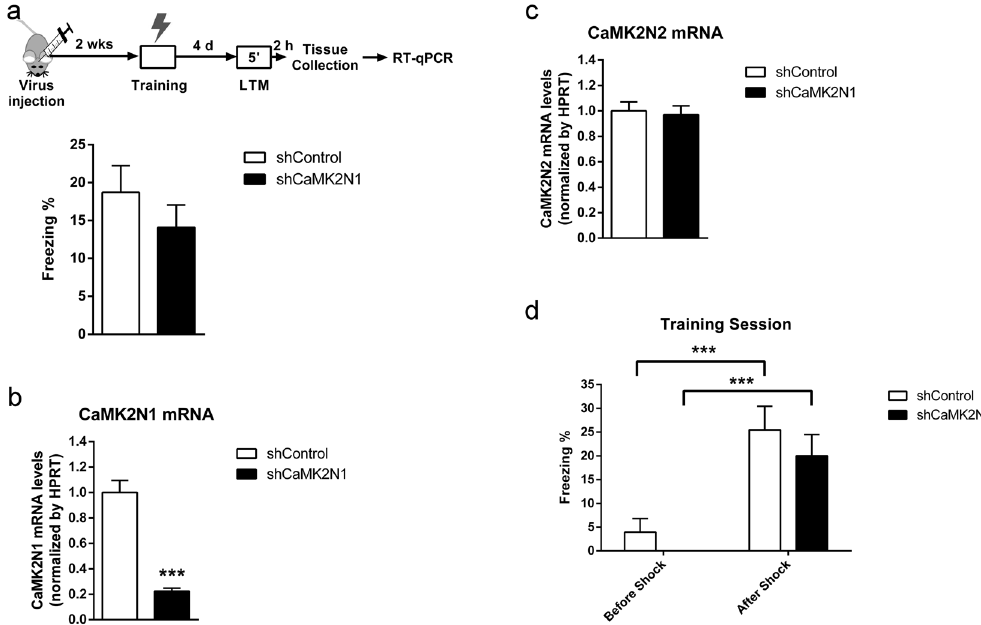
Figure 1. CaMK2N1 shRNA expression in dorsal hippocampus does not affect contextual fear LTM formation, storage and retrieval. ( a ) Dorsal hippocampi of mice were transfected with rAAV expressing either control shRNA (n = 19) or CaMK2N1 shRNA (n = 20). Contextual fear LTM was determined 4 days after conditioning. ( b ) Quantitative analysis of CaMK2N1 mRNA expression in dorsal hippocampi of animals from ( a ) (shControl, n = 19; shCaMK2N1, n = 20). ( c ) Quantitative analysis of CaMK2N2 mRNA expression in dorsal hippocampi of animals from ( a ). (shControl, n = 19; shCaMK2N1, n = 20). ( d ) Freezing scores obtained during conditioning of the animals from ( a ). Training session is divided here between before and after the shock. No animal in the shCaMK2N1 group presented any freezing before shock, resulting in a mean freezing of 0 and 0 of S.E.M. Two- way ANOVA test with repeated measures revealed a significant effect of the foot-shock (F 1,37 = 32.0; P < 0.001), with no effect of rAAV treatment (F 1,37 = 1.7; P = 0.120) or interaction between these two factors (F 1,37 = 0.0; P = 0.84). SNK post-hoc comparisons revealed a significant increase in freezing scores between before and after the shock for both shControl (n = 19) (q = 5.7; P < 0.001) and shCaMK2N1 (n = 20) (q = 5.5; P < 0.001)